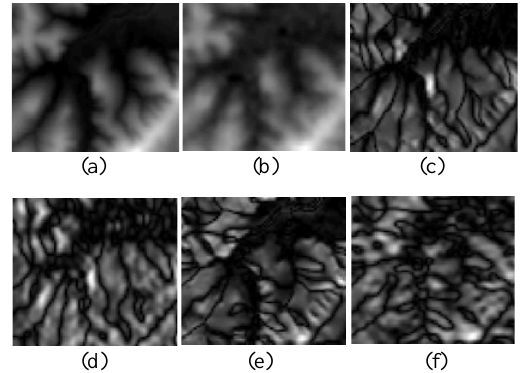
Figure 1. (a) and (b) show reference and target DEMs at 30m post spacing at the size of 70×80 pixels; (c) and (e) show gradient magnitude images of the reference DEM in x and y directions; and (d) and (f) display gradient magnitude images of the target DEM in x and y